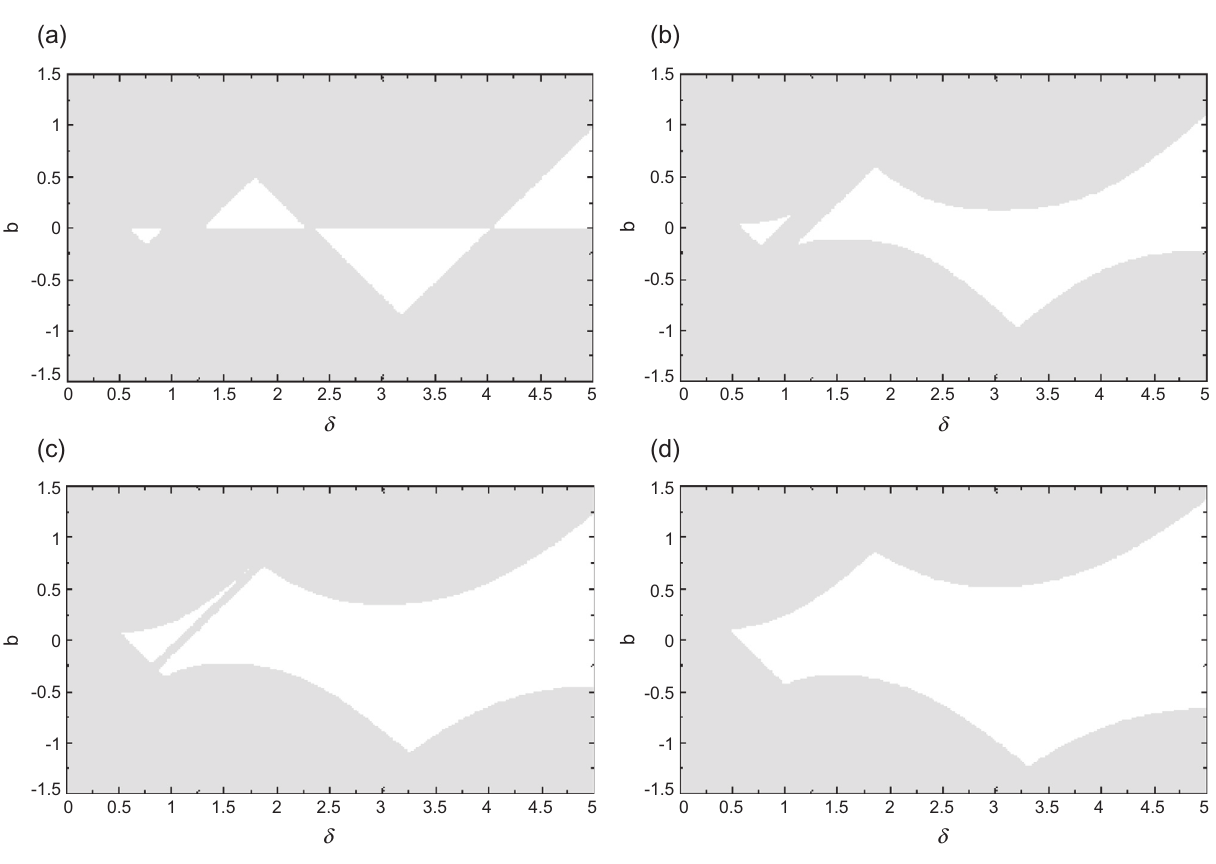
Figure 7. Stability charts of equation (55) from FTRM with (cid:2) = 1, x = 1 when (a) damping coefficient j = 0, (b) j = 0.1, (c) j = 0.2 and (d) j = 0.3. The sub-domains of stability are white while those of instability are